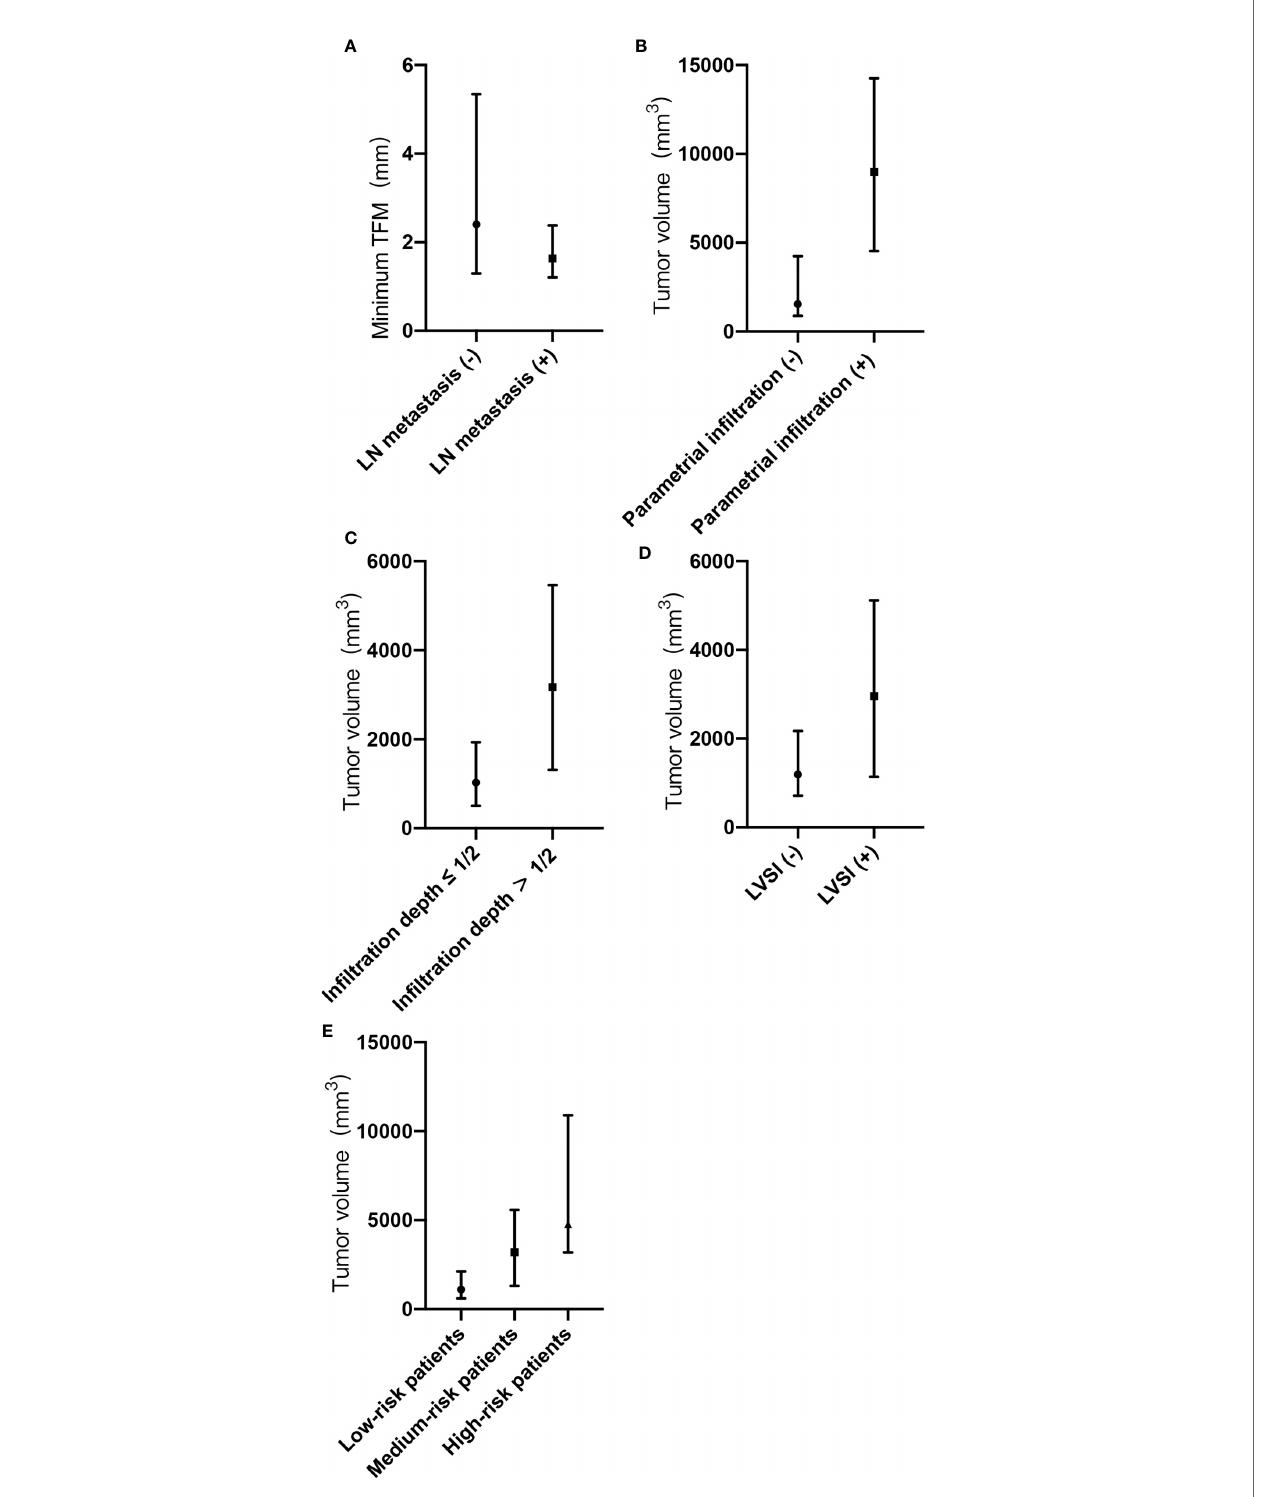
FIGURE 2 | (A-E) Minimum tumor-free margin (TFM) and tumor volume with adverse pathological risk factors and risk grading. (A) Minimum TFM in groups with or without lymph node metastasis. (B) Tumor volume in groups with or without parametrial in fi ltration. (C) Tumor volume in groups with or without deep cervical in fi ltration. (D) Tumor volume in groups with or without lymph vascular space invasion. (E) Tumor volume in groups of low-risk, medium-risk, and high-risk patients. TFM, tumor-free margin; LN, lymph node; LVSI, lymph vascular space invasion; (-), negative; (+),